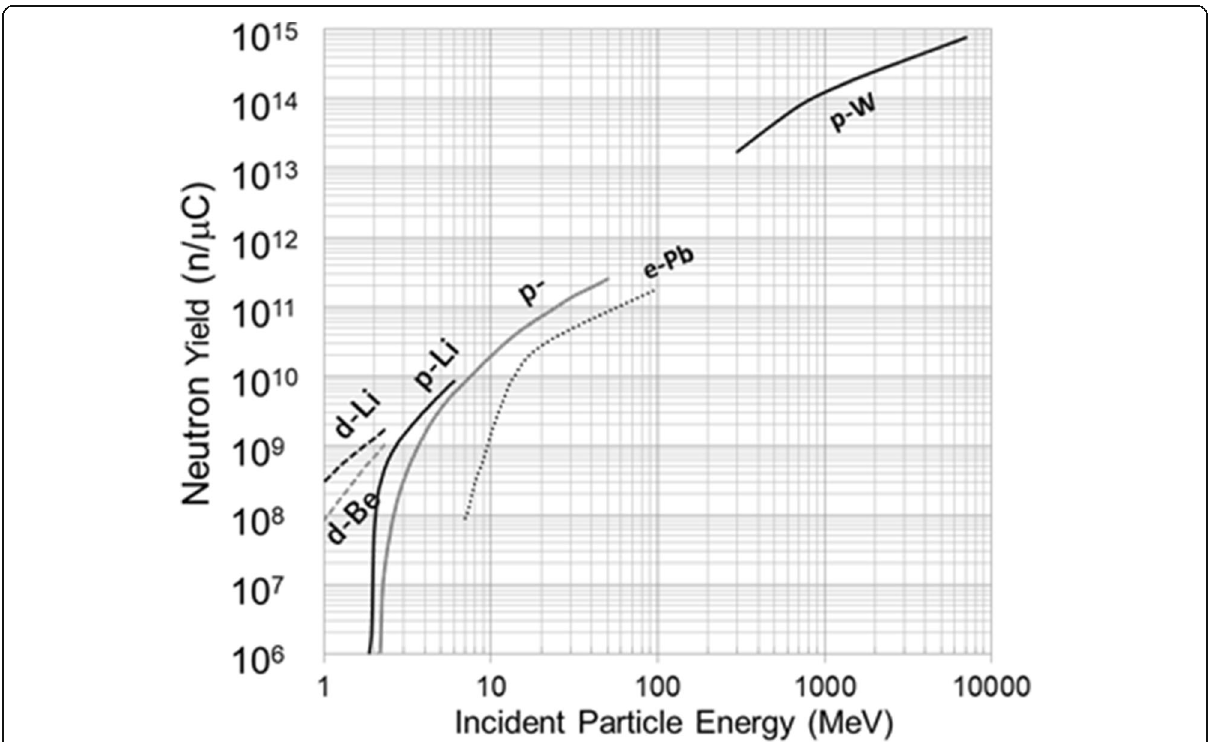
Fig. 3 Neutron yield as a function of incident particle